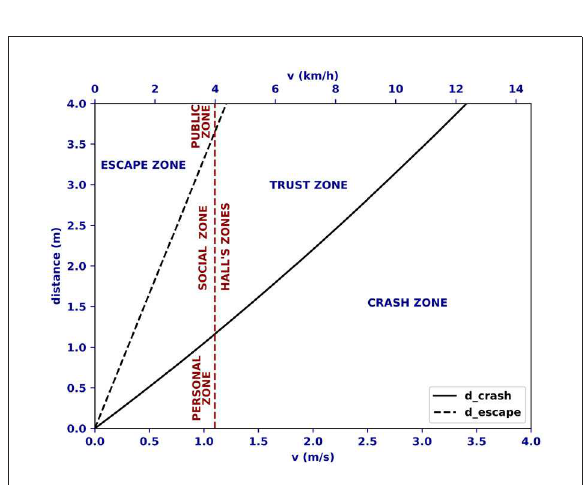
FIGURE12 Distances ( d crash and d escape ) and zones predicted by the PTR model for different car speeds v at lower speeds. If the vehicle is set to drive at the same speed v = 1.1 = v ped m/s as a pedestrian, then the PTR zones closely match Hall proxemic zones, as shown by the vertical red line (Camara and Fox,